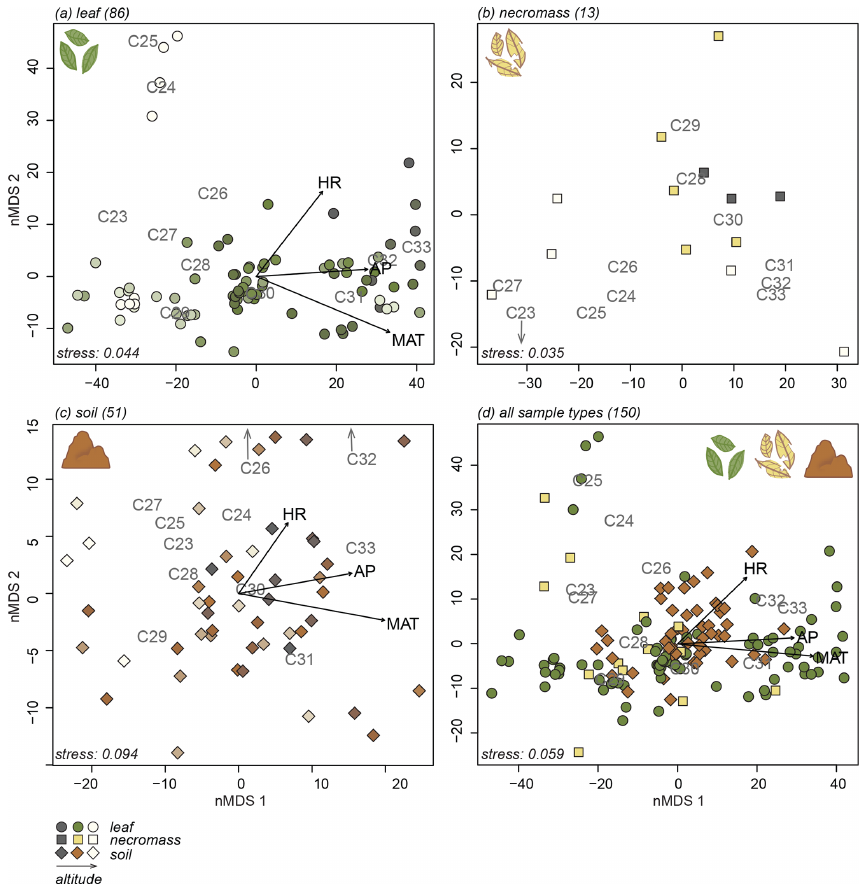
Figure 3. nMDS plots of n -alkane patterns per sample type (a, b, c) and all sample types combined (d) . Numbers in parentheses next to sample type represent number of samples. Arrows indicate fit of environmental variables, altitude (ALT), temperature (MAT), humidity (HR) and precipitation (AP). Text indicates n -alkane chain length contribution to sample. Samples indicated by symbols, sample type indicated by symbol colour and shape (green circles = leaf, yellow squares = necromass, brown diamonds = soil). Colour gradient in panels (a) , (b) , and (c) indicate altitude (darker = lower, lighter =